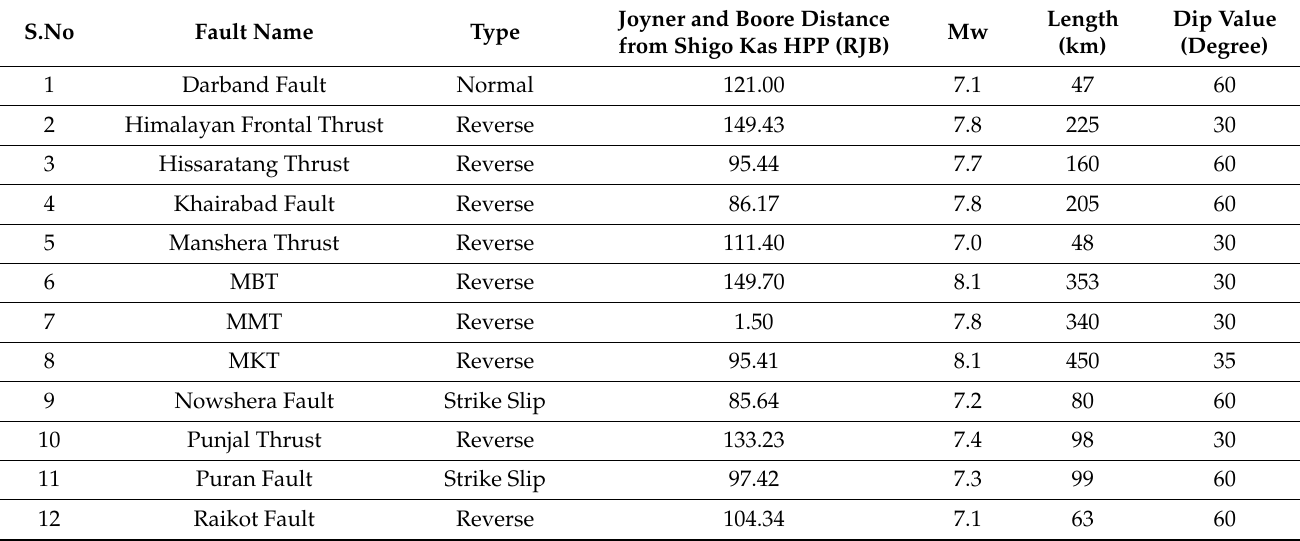
Table 2. Faults within a 150 km radius of Shigo Kas